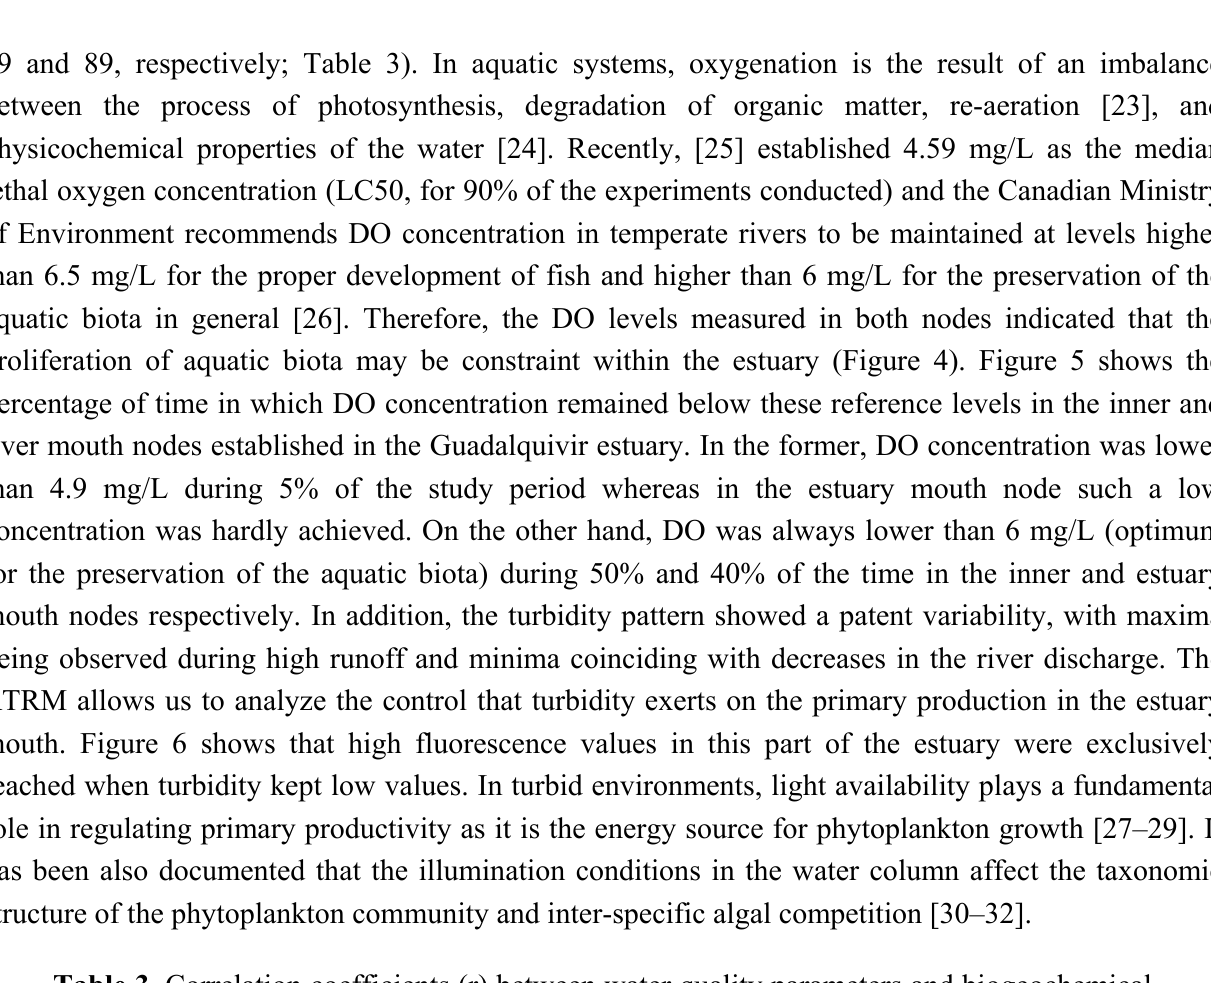
Table 3. Correlation coefficients (r) between water quality parameters and biogeochemical variables. Values marked with asterisk or cross are statically significant at P < 0.05 and P < 0.01 respectively. The rest of values are not